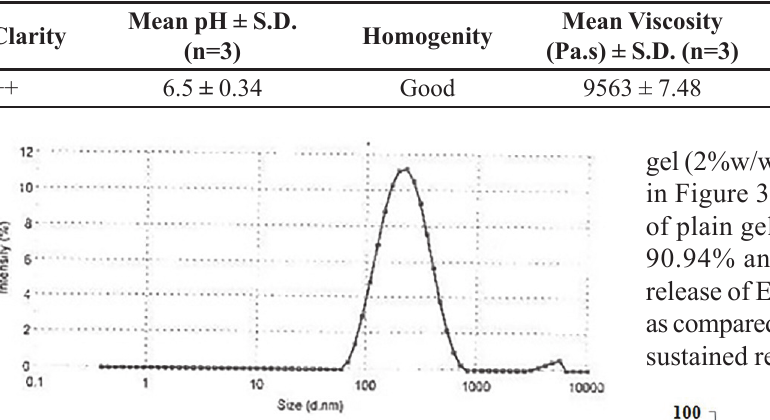
FIGURE 1 - Particle size of optimized formulation (F4).